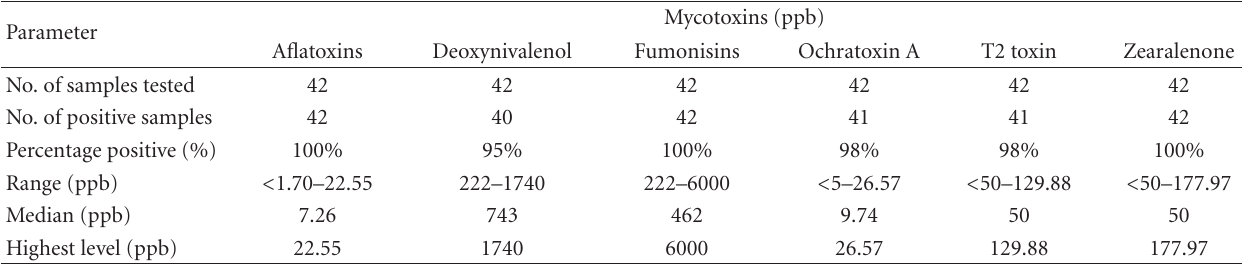
Table 4: Number of samples tested, number of positive samples, and percentage and levels of detected